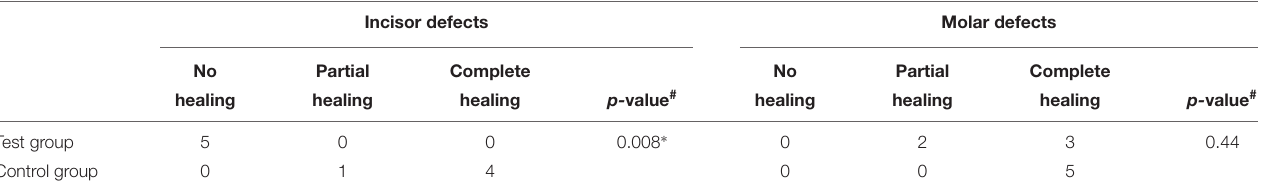
TABLE 1 | Distribution of the type of healing of the defects in the test and control groups. Incisor defects Molar